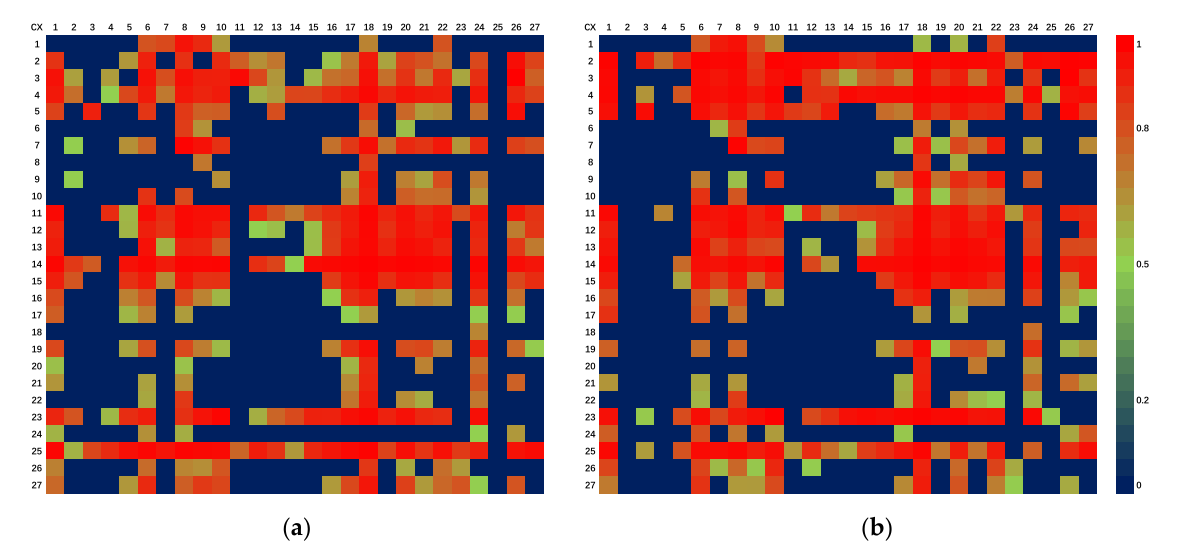
Figure 6. Pairwise control relationships between sectors of pollutant emissions. ( a ) NO x ; ( b ) PM.